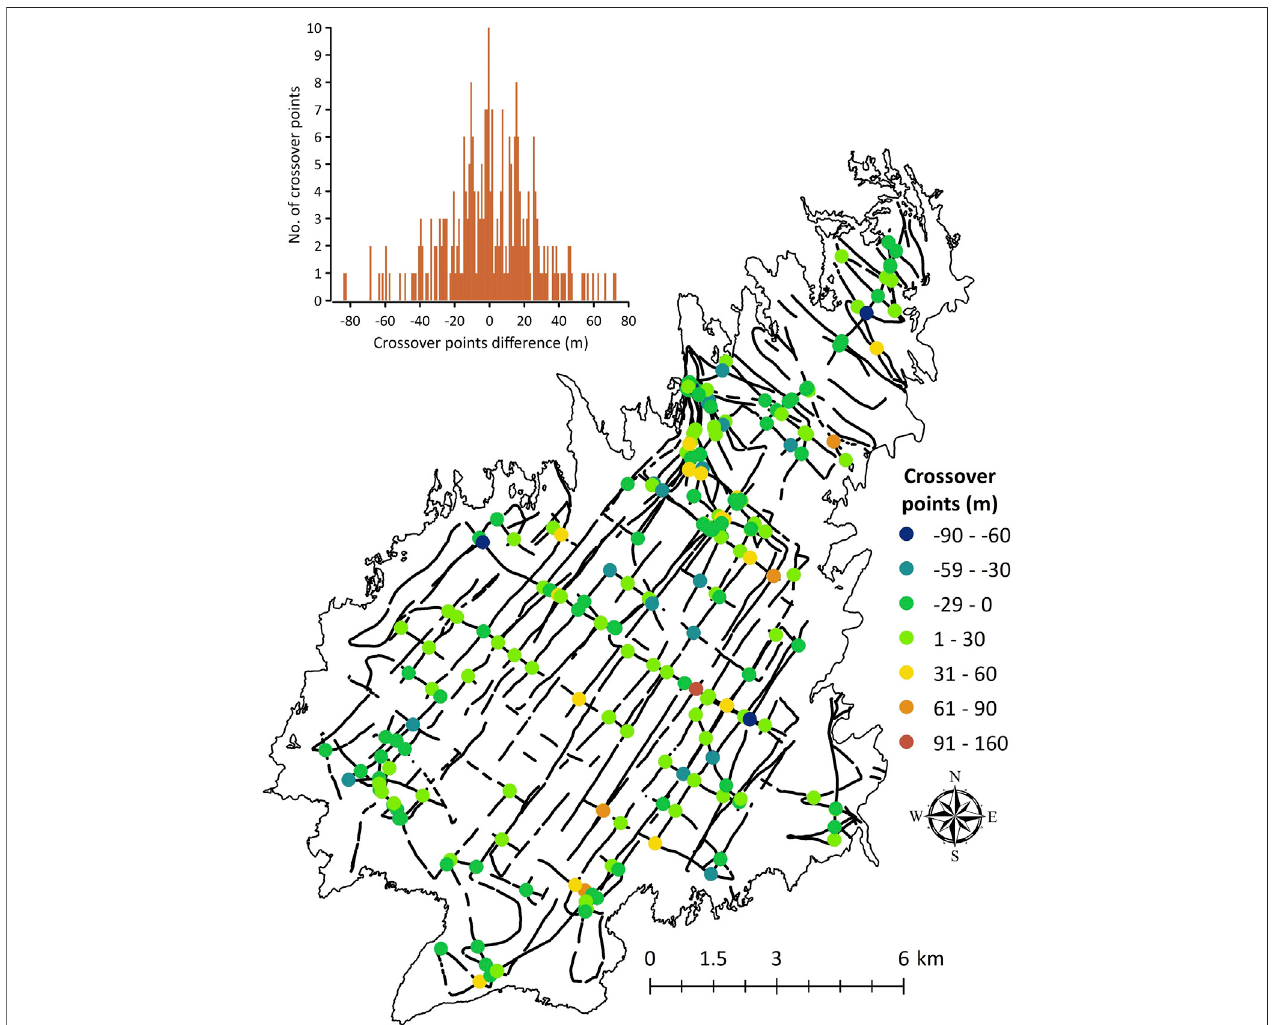
FIGURE 2 | Crossover points found between crossing radar pro fi les (ice thickness, m). Note that the legend range changes at the last two dots. The histogram (upperleftcorner)showsthedistributionofthecrossoverdifferencesinmeters.Mostpointshaveacrossoverpointdifferenceoflessthan40 m(theaverageis20 m,and the median is 15 m). The black lines illustrate all pro fi les used for the interpolation of subglacial bed topography.